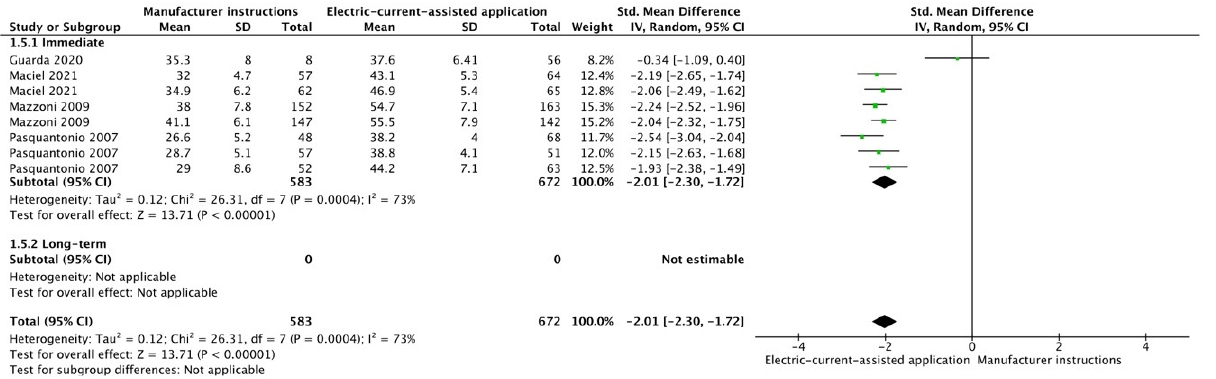
Figure 5. Forest plot showing the bond strength values when the adhesive was applied using an electric current.